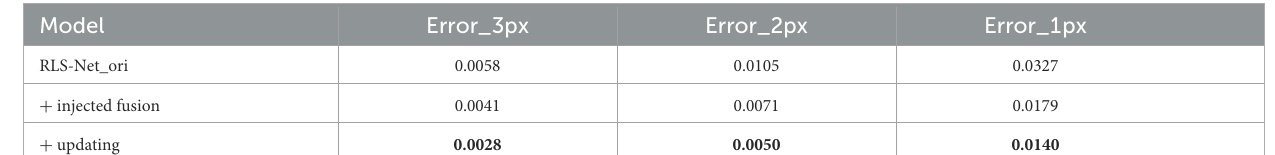
TABLE 5 Results of the injected guided updating module.